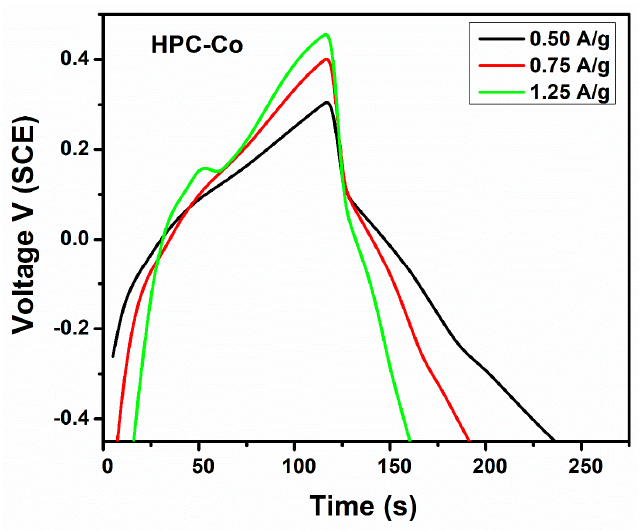
Figure 15. Galvanostatic charge–discharge V-t curves of HPC-Co (1) at 0.25 A/g, 0.75 mA, and 1.25 A/g current densities.